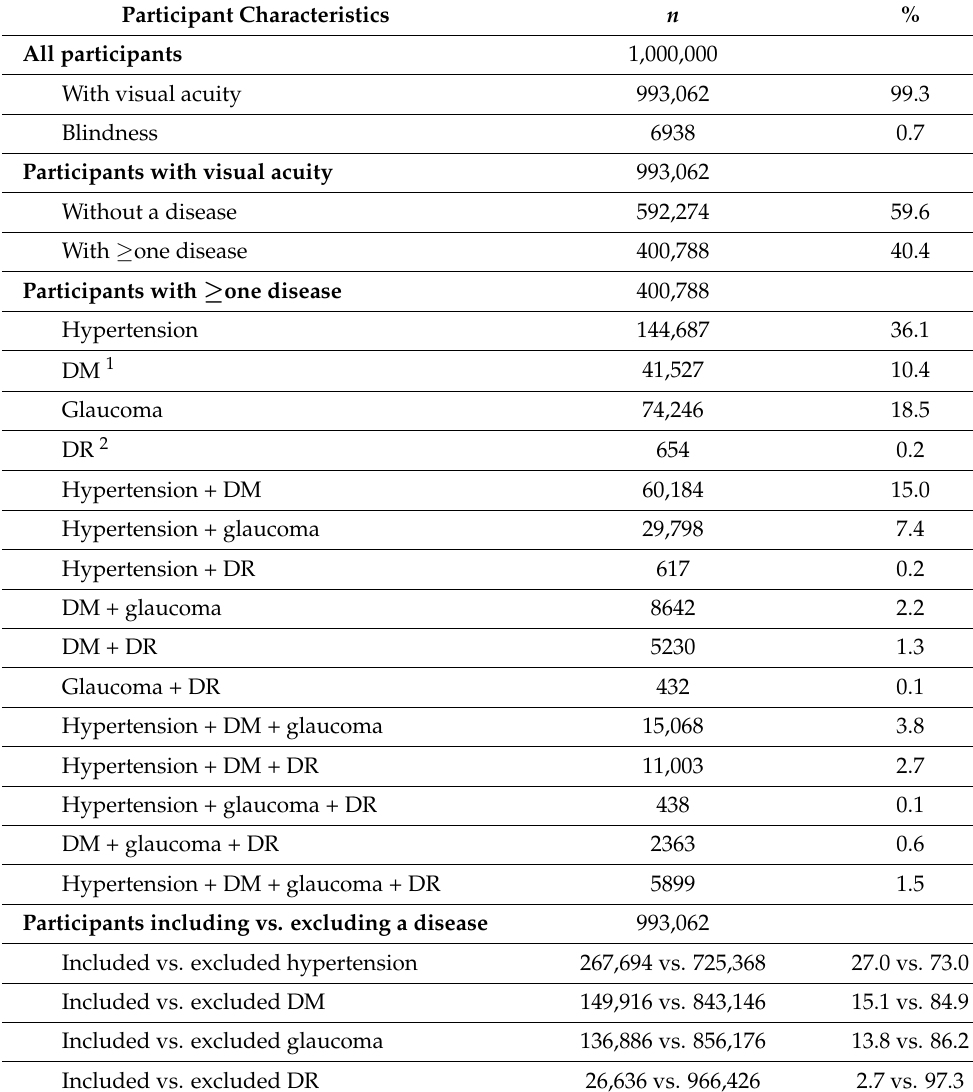
Table 1. Participant characteristics and distribution of diseases associated with reduced visual